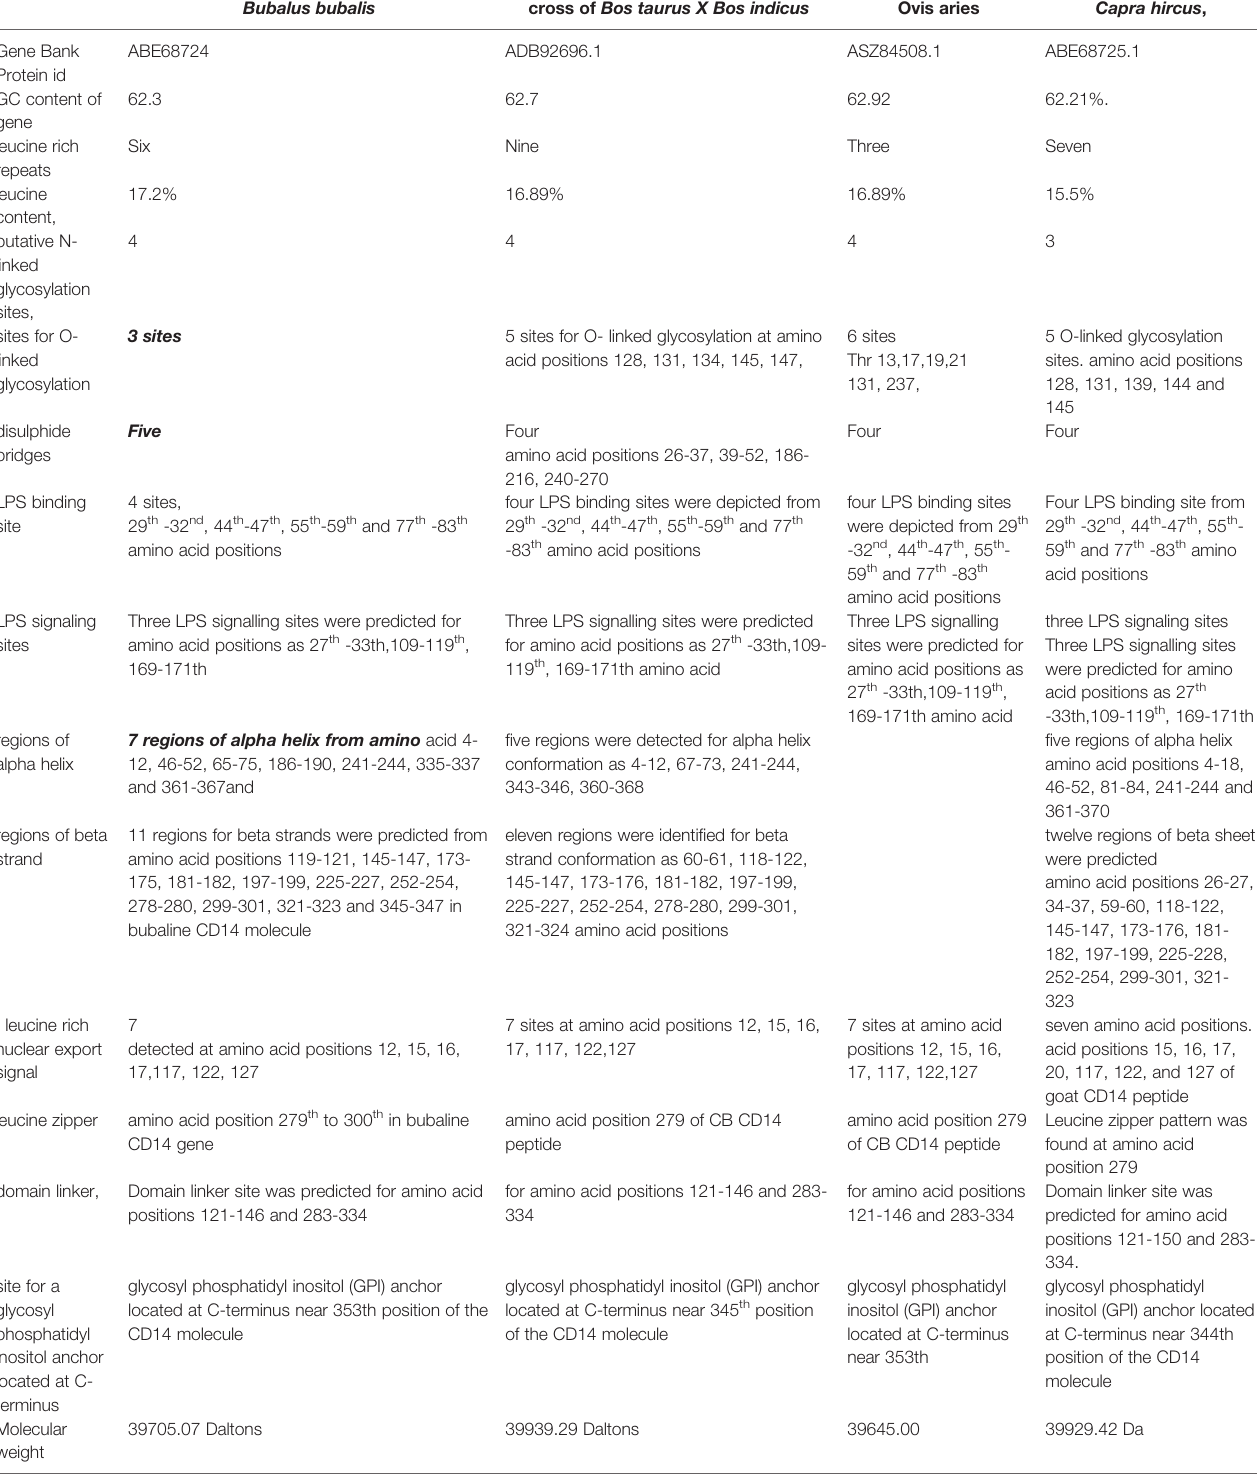
TABLE 2 | Bioinformatics analysis of CD14 derived peptide for domestic